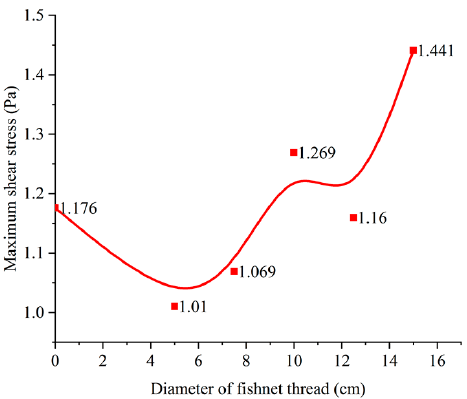
Figure 13. Influence of the fishnet thread diameter on the maximum shear stress on the surface of the seabed.